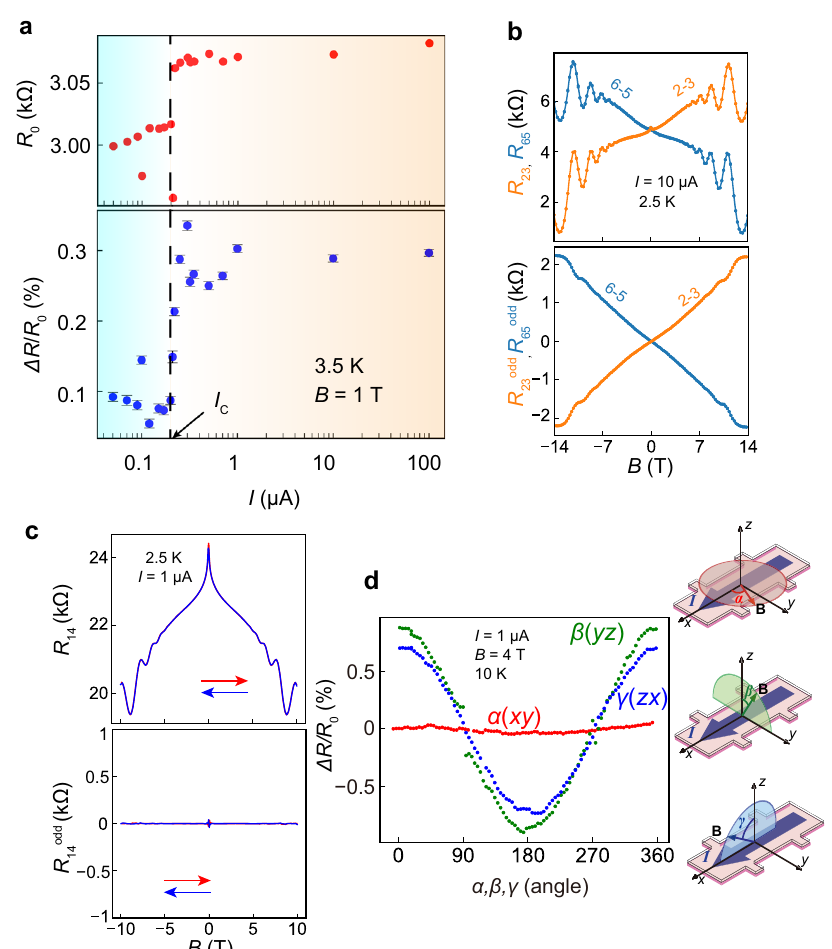
Fig. 2 | Propertiesofthe OMR in 1D InAs edge channels. a Current I dependence of the zero fi eld resistance R 0 (upper panel) and the OMR magnitude Δ R / R 0 (= [( R 23 (1T) − R 23 ( − 1T))/2]/ R 0 ) (lower panel) measured in R 23 of sample B at 3.5K. The R 0 and Δ R / R 0 jumpup at I C (=200nA)simultaneously. The errorbars are obtained from the covariance of the linear fi tting of the OMR. b Comparison of the B- dependences of R 23 and R 65 (upper panel) of sample A and their odd-function components (lower panel) measured with a fi xed current of 10 μ A at 2.5K. R 23 and